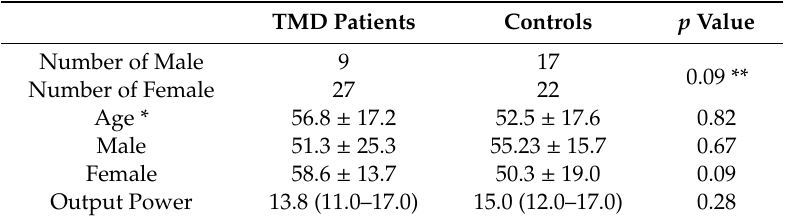
Table 1. Comparison between temporomandibular disorders (TMD) patients and control subjects according to number of participants, age, and output Power of TENS